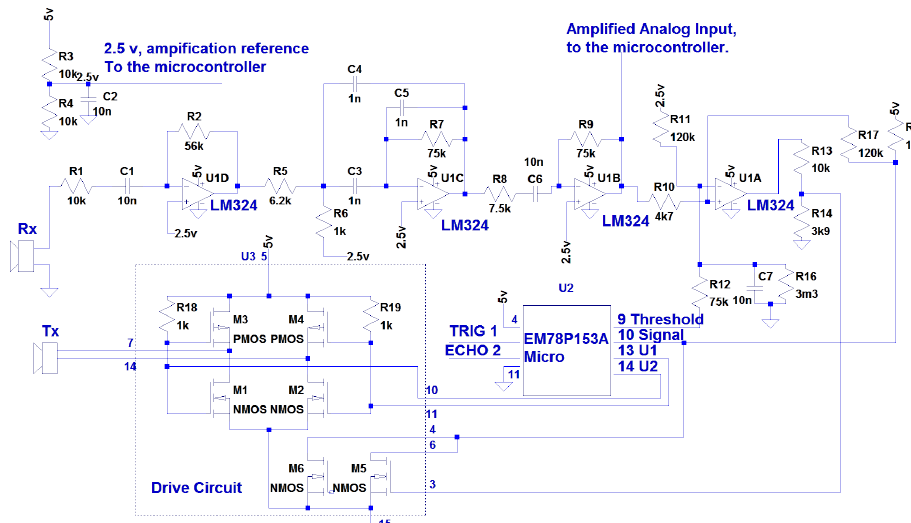
Figure 11. HC-SR04 circuit